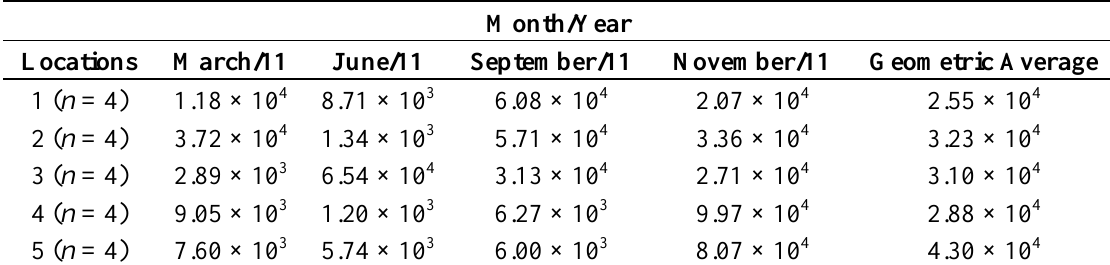
Table 2. Number of HAdV gc/L in mineral water collected from 20 L containers over a period of four months in